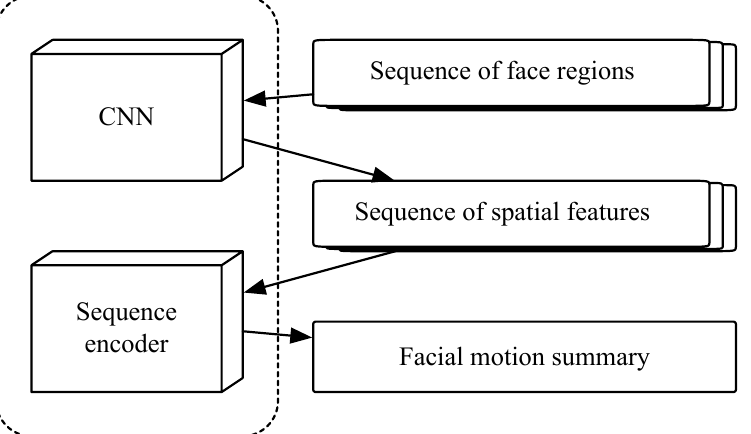
Figure 1. Network architecture. The CNN part uses MobileFaceNet [6] as the backbone and is pre- trained for the facial landmark detection task ahead. The sequence encoder contains two transformer layers and one max-pooling layer (applied to the time axis). The final output of this network is a 1D vector representing the facial motion information in the input